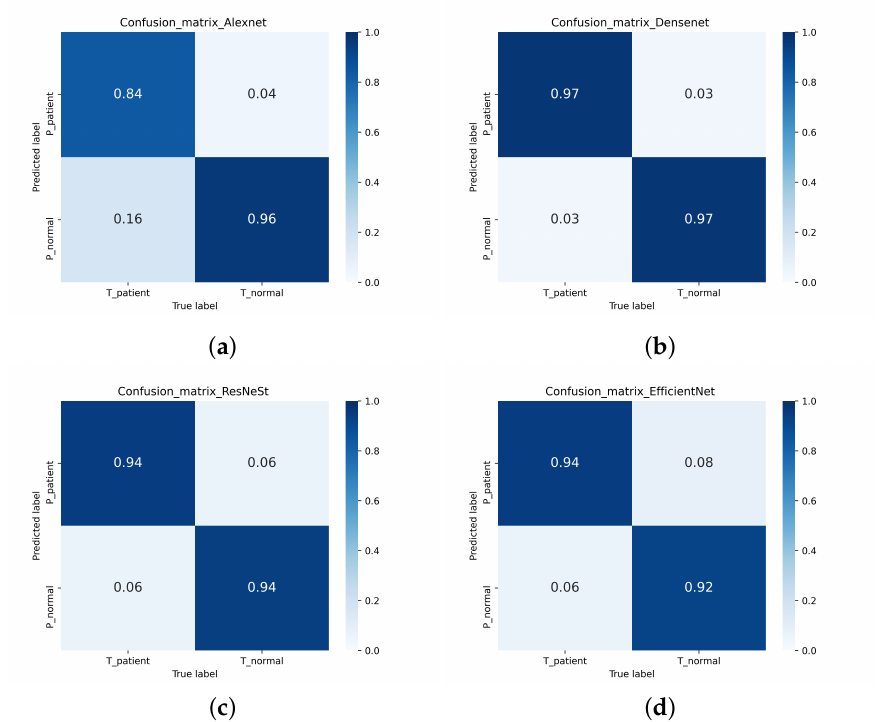
Figure 16. The confusion matrix of the multi-modal data set. ( a ) Alexnet ( b ) Densenet ( c ) ResNeSt ( d )